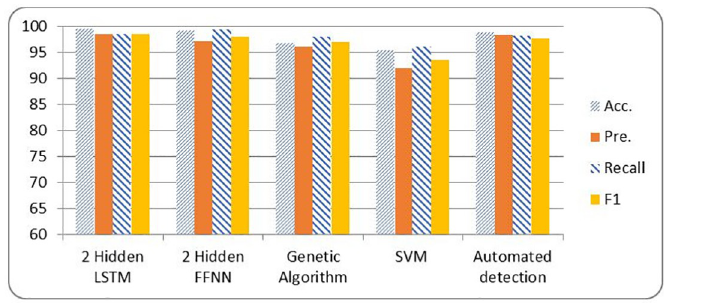
Fig 11. SDN metrics comparison among different classification